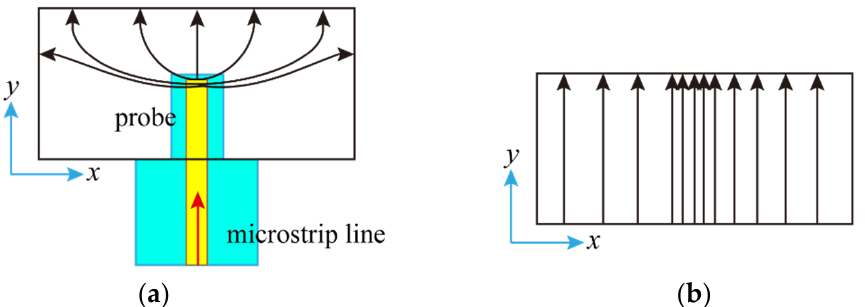
Figure 1. The electric field distribution of different structures. ( a ) The probe embedded in waveguide. ( b ) The TE 10 mode of rectangular waveguide.